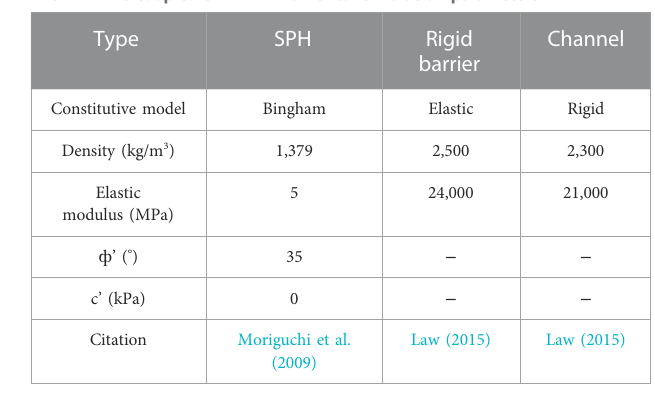
TABLE 2 The coupled SPH-FEM numerical simulation